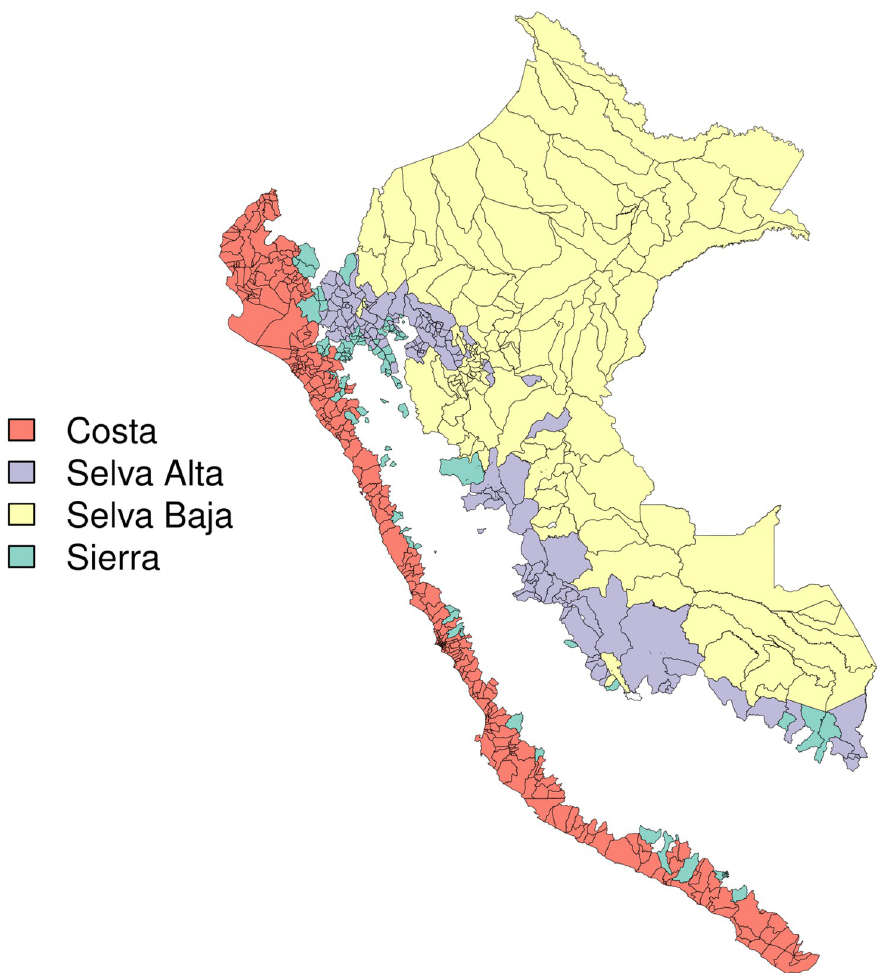
Fig 4. Natural region, merged districts in Peru (n = 1,834), January 2000-September 2018. Base map source: GEOSS Information Exchange Data